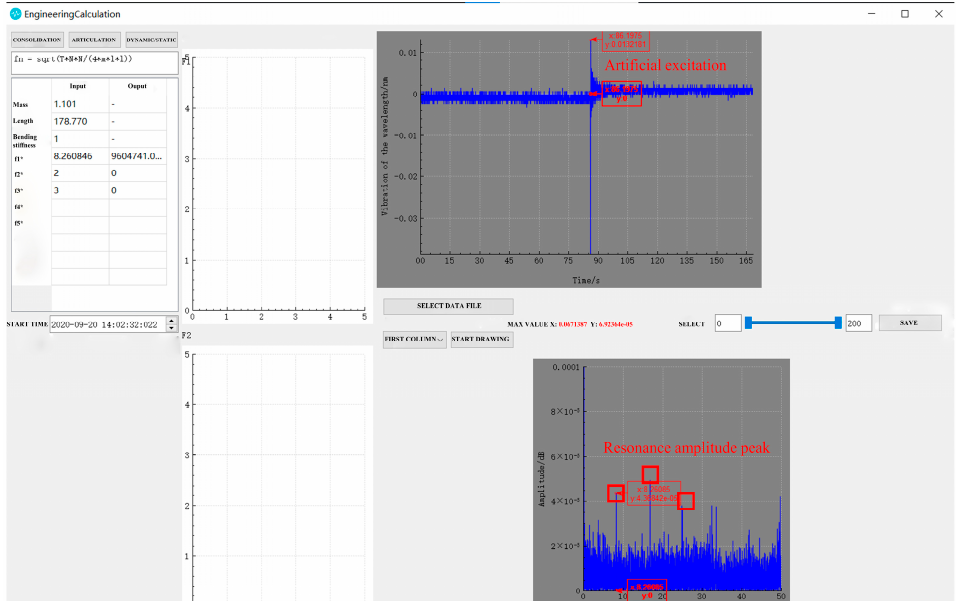
Figure 8. Data processing software interface.